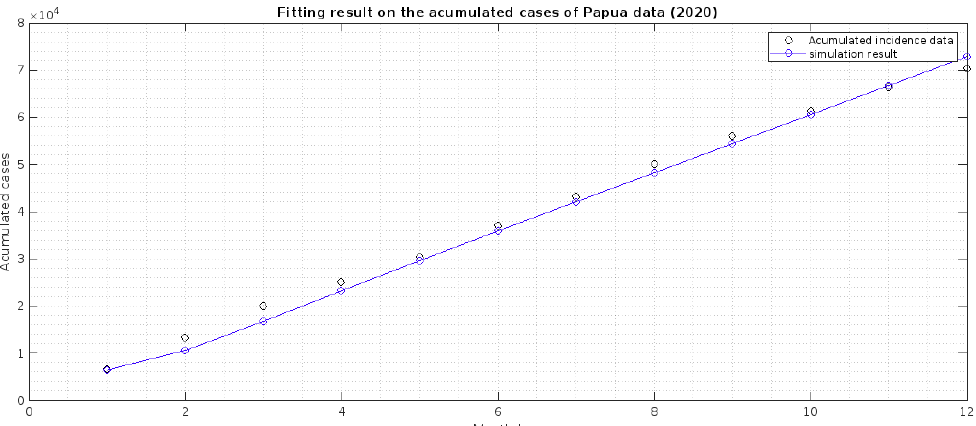
Figure 2. Estimation result on fitting the accumulated cases in Papua with c ( t ) in Equation (3). The best-fit initial conditions for S 1 , E 1 , I , T , R 1 , R 2 , V , W are 3,435,430, 2000, 2000, 2000, 1000, 21, 6,870,860, 3000,